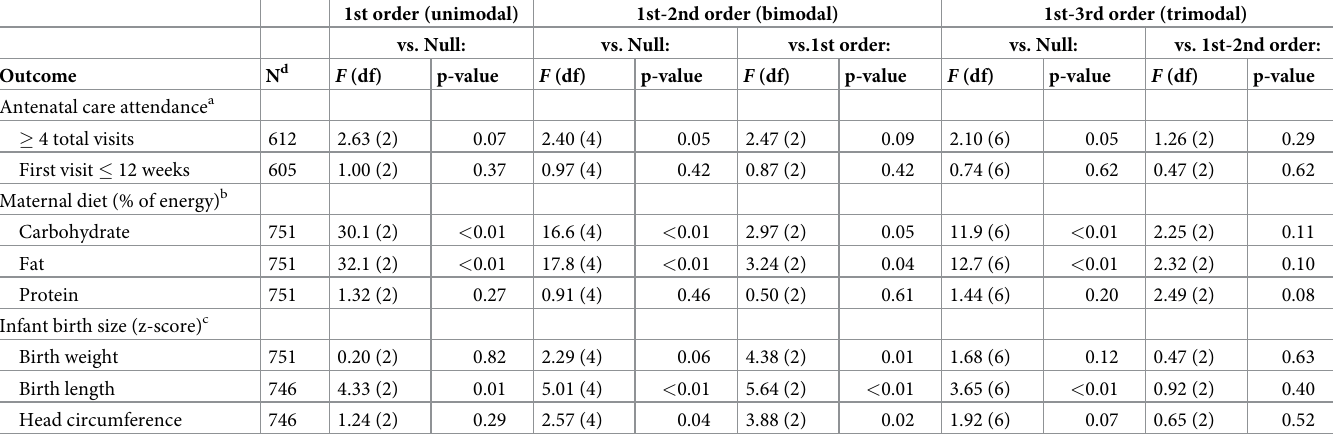
Table 3. Comparison of truncated Fourier series models for seasonality of antenatal care attendance, maternal dietary intake, and infant birth size, VHEMBE study, South Africa, 2012–2013. 1st order